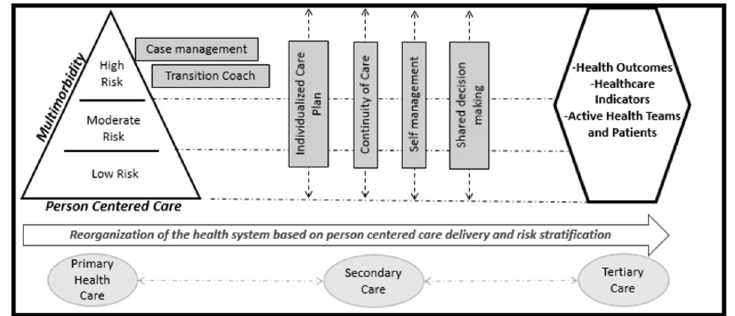
Fig 1. Multimorbidity patient centered care